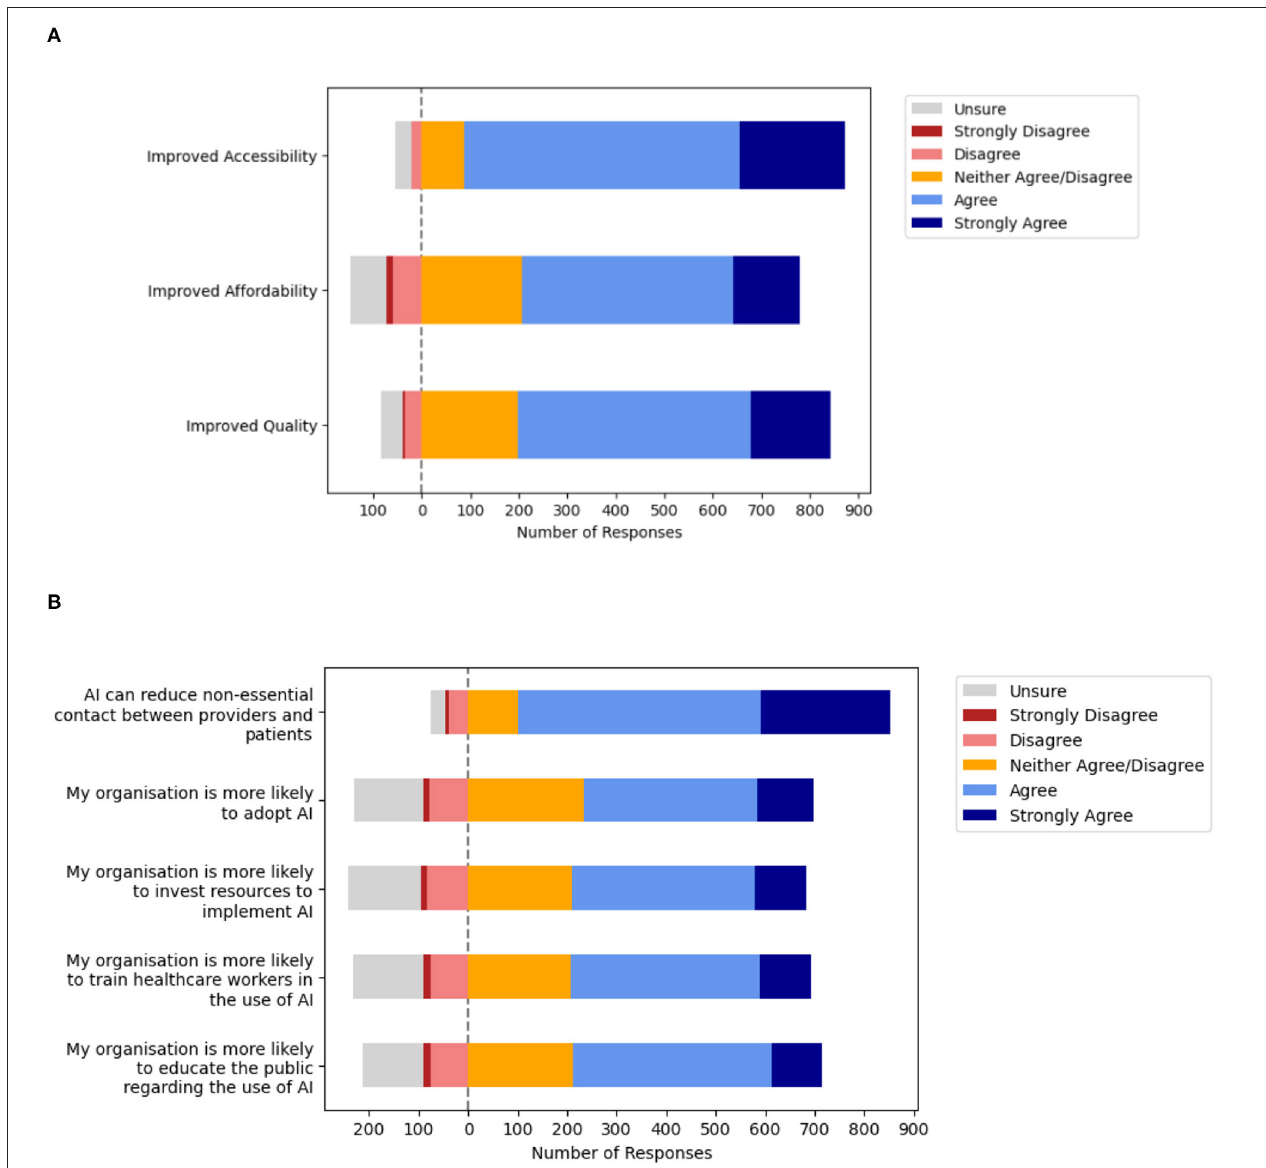
FIGURE 5 | Macrosystem—Ophthalmologists perceptions about artificial intelligence (AI) and the impact of the pandemic on adoption within health systems. (A) Value of clinical artificial intelligence (AI) perceived by Ophthalmologists. (B) Impact of the coronavirus disease 2019 (COVID-19) on health system adoption.